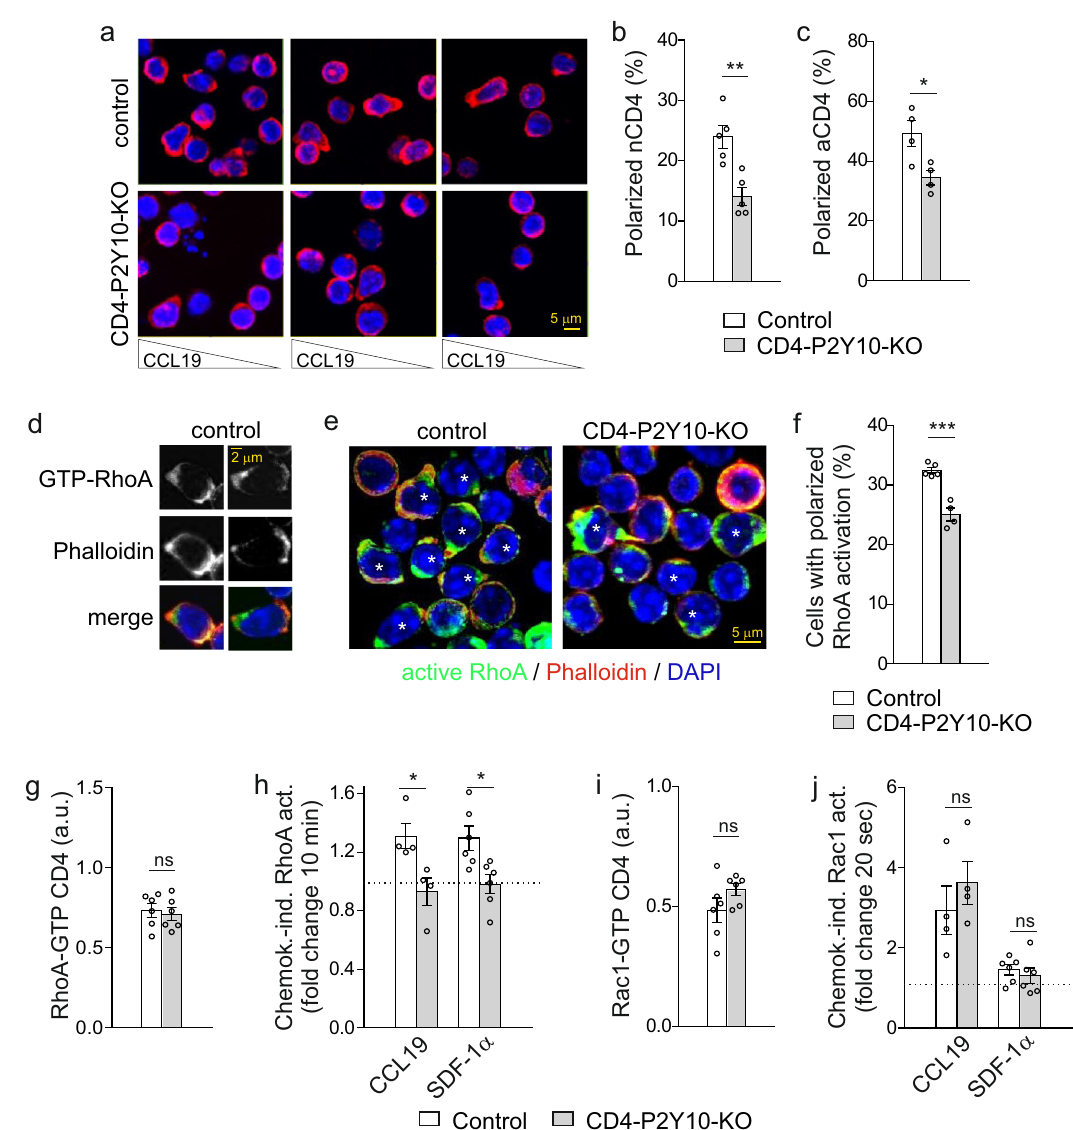
Fig. 4 Reduced chemokine-induced RhoA activation in P2Y10-de fi cient CD4 T cells. Phalloidin staining of nCD4 ( a , b ) or aCD4 ( c ) that were allowed to migrate for 10 min towards a CCL19 gradient in μ -Slide Chemotaxis chambers: representative photomicrographs ( a ) and quanti fi cation of the percentage of polarized cells in nCD4 ( b ; **, p = 0.003) and aCD4 ( c ; *, p = 0.024) (4 – 5 mice per group were analyzed in 4 – 5 independent experiments, and per experiment 57 – 259 cells (nCD4) and 32 – 230 cells (aCD4) were evaluated). d – f Distribution of active RhoA in CCL19 (10 min)-stimulated CD4 T cells (homogenous CCL19 environment): d Examples showing active RhoA and phalloidin staining in CCL19-polarized control cells; exemplary photomicrographs ( e ) and statistical evaluation ( f ; ***, p < 0.001) of cells with polarized RhoA activation (a total of 492 and 302 cells from two mice per group were analyzed (59 – 124 cells per data point); * indicates cells considered polarized). Basal levels ( g , i ) and chemokine-induced changes ( h , j ) of active, GTP-bound RhoA ( g , h ) and active, GTP-bound Rac1 ( i , j ) (4 – 6 mice per group; h , *, p = 0.024 (CCL19); *, p = 0.013 (SDF-1 α )). Data are means± SEM; comparisons between genotypes were performed using two-tailed unpaired Student ’ s t- test. *, P <